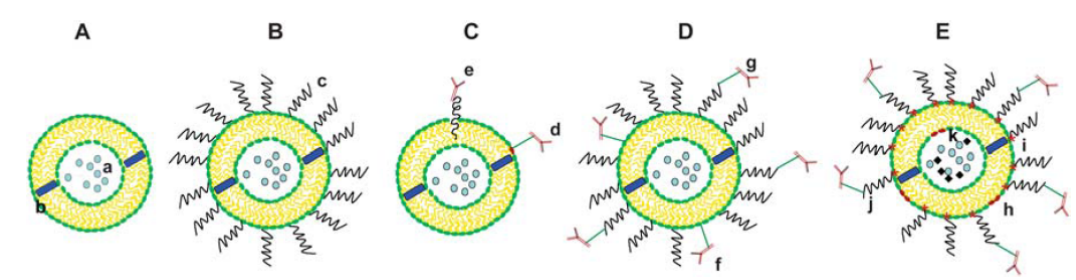
Figure 2. Evolution of liposomes. ( A ) Early conventional ‘plain’ phospholipid liposomes with water-soluble drug (a) entrapped within the aqueous liposome interior, and water-insoluble drug (b) incorporated in the liposomal membrane. ( B ) Long-circulating liposome grafted with a protective polymer (c) such as polyethylene glycol (PEG), which shields the liposome surface from the interaction with opsonizing proteins. ( C ) Antibody-targeted immunoliposome with antibody covalently coupled (d) to the reactive phospholipids in the membrane, or hydrophobically anchored (e) in the liposomal membrane after preliminary modification with a hydrophobic moiety. ( D ) Long-circulating immunoliposome simultaneously bearing both a protective polymer and an antibody (f) or, preferably, antibody bound to the distal end of a grafted polymeric chain (g). ( E ) “Smart” liposome, the surface of which can be modified (separately or simultaneously) by the incorporation of stimuli-sensitive lipids such as temperature, pH, reduction sensitive lipids (h); modification with a detachable